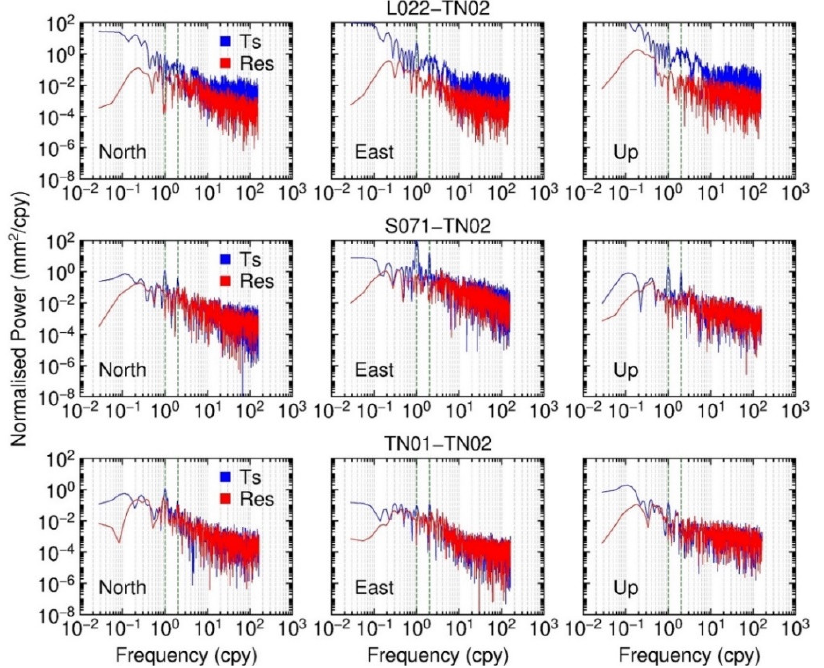
Figure 5. Baseline coordinate time-series power spectra of L022–TN02, S071–TN02 and TN01–TN02, where the x -axis is frequency with the unit of cycles per year, and the y -axis is the normalized power. The blue lines are the baseline time series, and the red lines are the residuals after removing the fitting models. The vertical green dashed lines indicate annual and semiannual frequency.